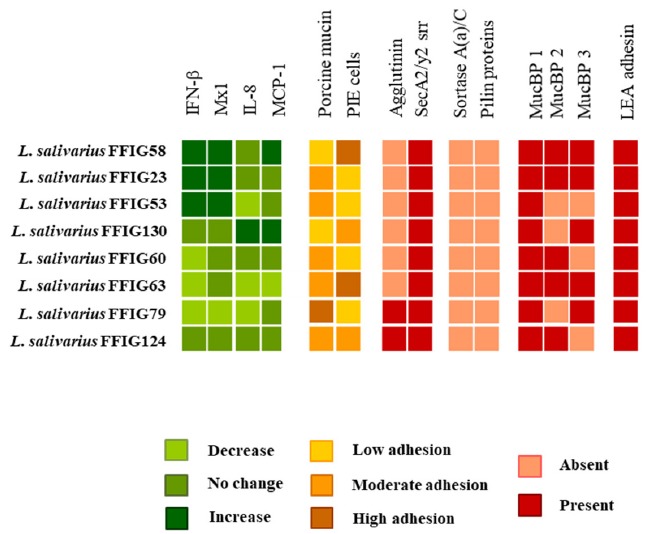
Figure 14. Comparison of the immunomodulatory and adhesion capabilities of Ligilactobacillus salivarius isolated from the intestinal mucosa of wakame-fed pigs.